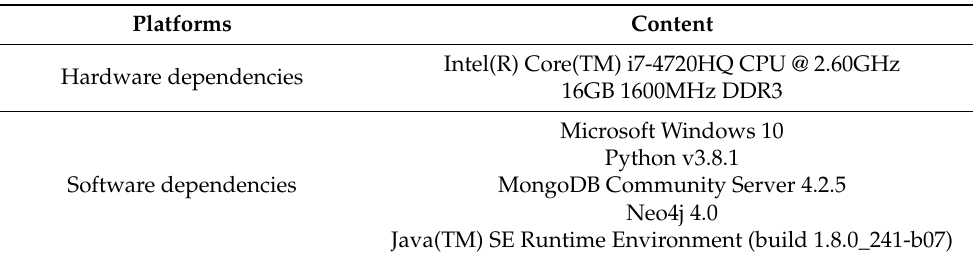
Table 3. Platforms environment.